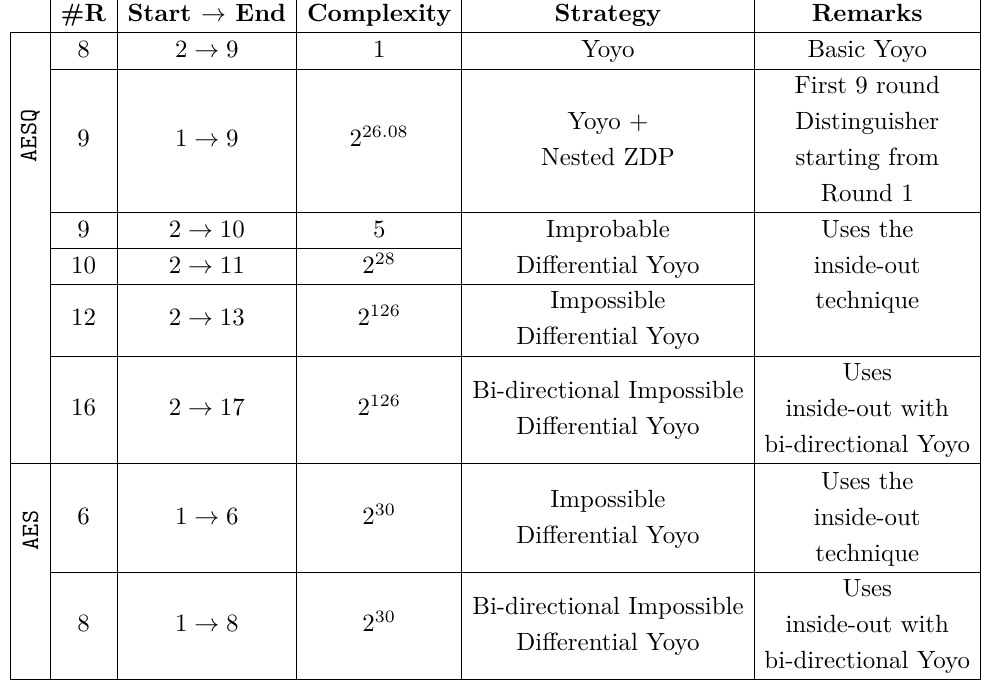
Table 4: Distinguishers reported in this